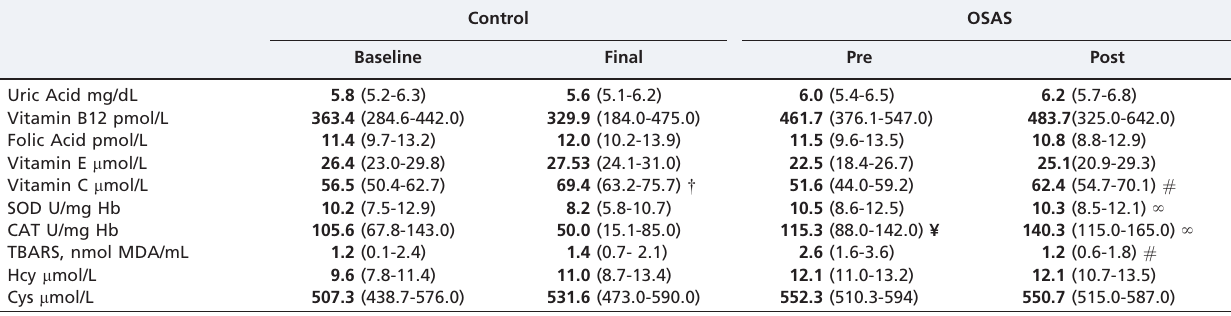
Table 5 - Baseline and final values of oxidative stress parameters for the control and obstructive sleep apnea syndrome (OSAS)